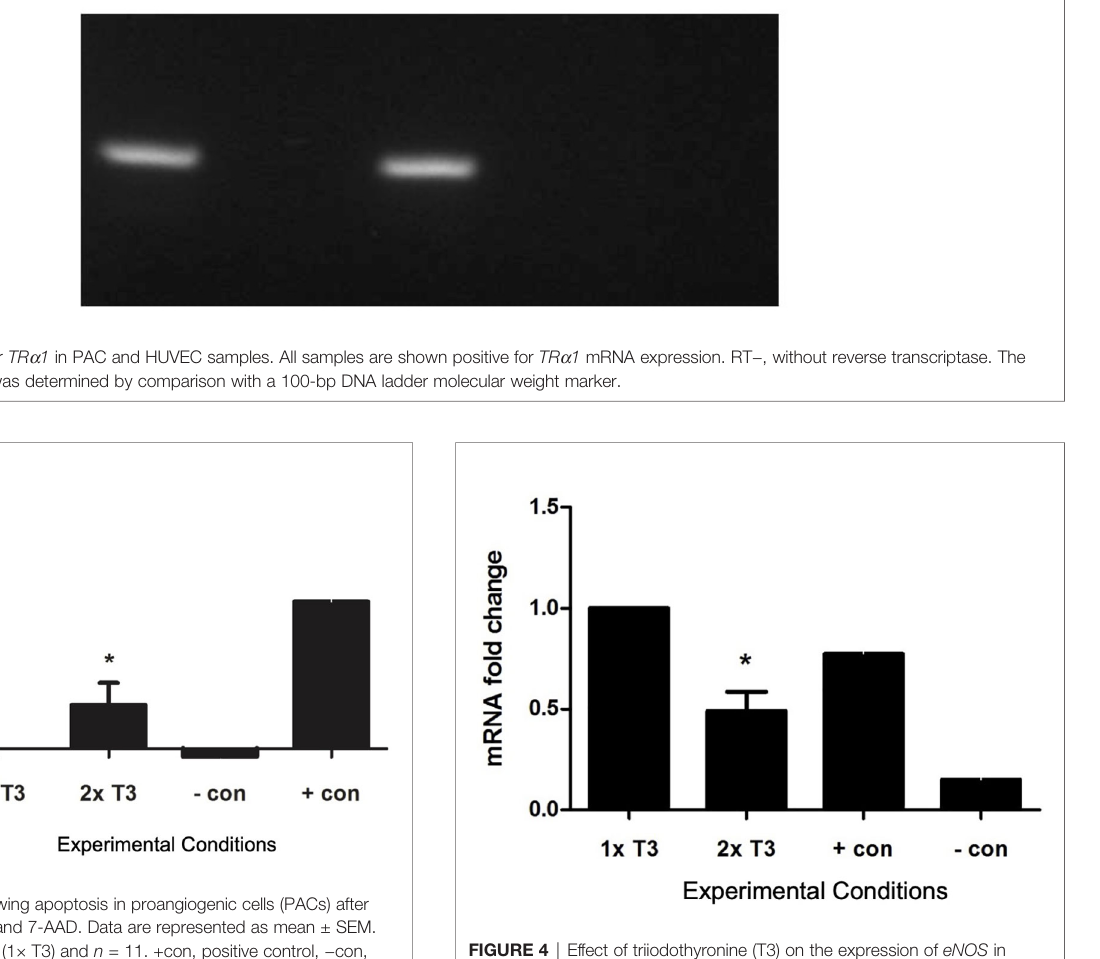
FIGURE 4 | Effect of triiodothyronine (T3) on the expression of eNOS in PACs. Gene expression was quanti fi ed by real-time PCR and normalized to TBP (reference gene TATA-box-binding protein). Data are represented as mean ± SEM. * p < 0.05 versus normal (1× T3). +con, positive control; − con, negative